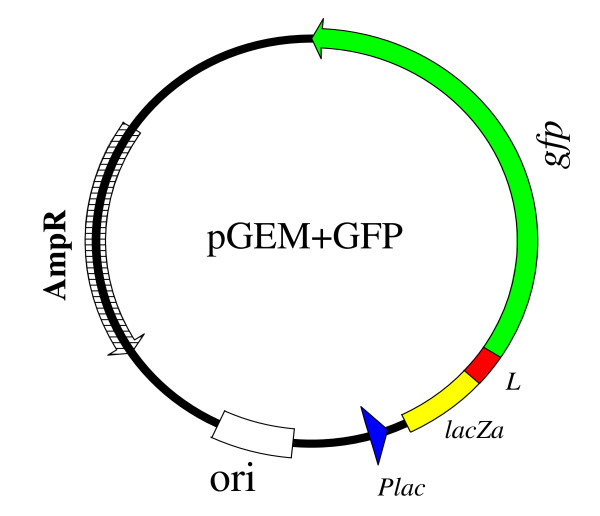
The GFP expression plasmid (pGEM+GFP). The gfp was fused in-frame to the β-galactosidase α-gene in pGEM-Teasy plasmid. A small linker (L) was included (in-frame) between the gfp and β-galactosidase α-gene (lacZa). E. coli lac (lactose) promoter was upstream the genes. A start codon was in the β-galactosidase α-gene and a stop codon was included at the end of the gfp gene. The expression cassette contained an E. coli origin of replication (ori) and ampicillin resistance gene (AmpR).